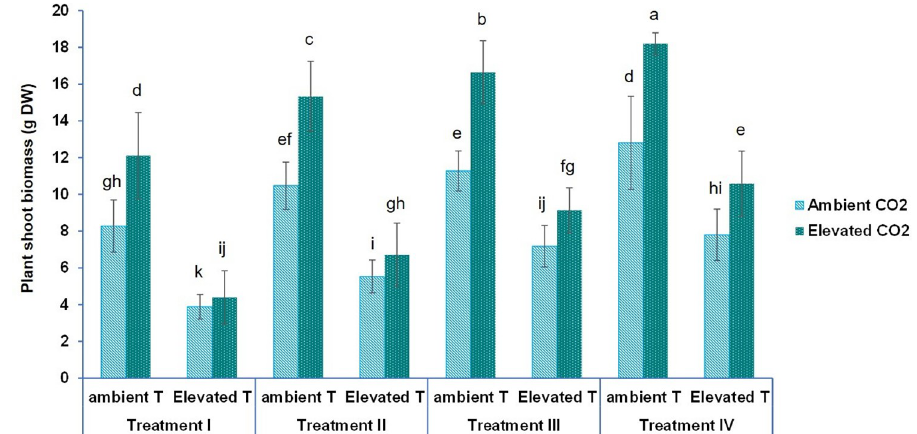
Fig 1. Effect of short-term heat stress, Two levels of [CO 2 ] and four different NO3-/NH4+ treatments (T-I: 100/0 NO3 − / NH4+; T-II: 100/0 NO3 − / NH4+ before short-term heat stress, when all the nitrate intake was replaced by sulphates; T-III: 80/20 NO3 − / NH4+ ratio and T-IV: 50/50 NO3 − / NH4+ ratios) on total dry weight of baby-leaf lettuce cv Derbi. Different letters are significantly different according to Tukey’s test at p � 0.05.